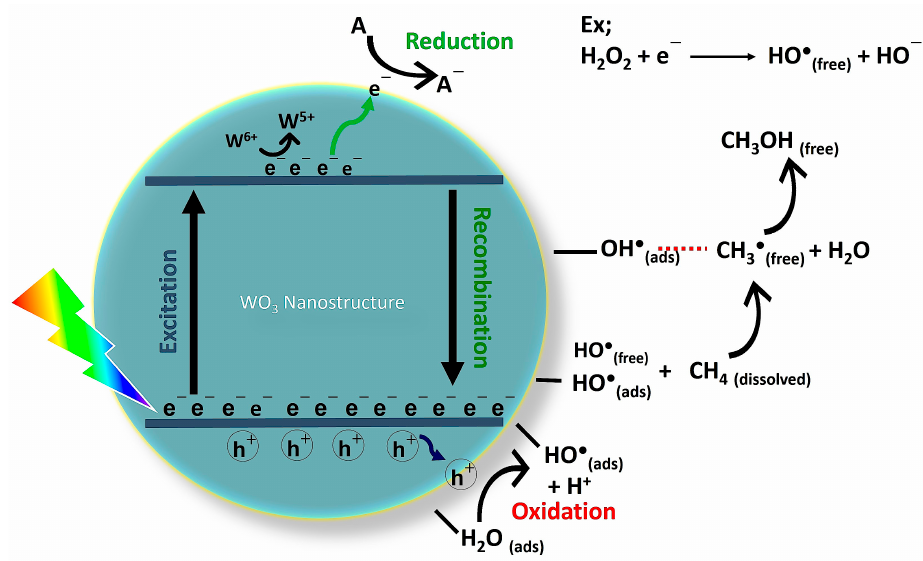
Figure 4. Schematic of the proposed mechanism of photocatalytic methane partial oxidation to methanol.